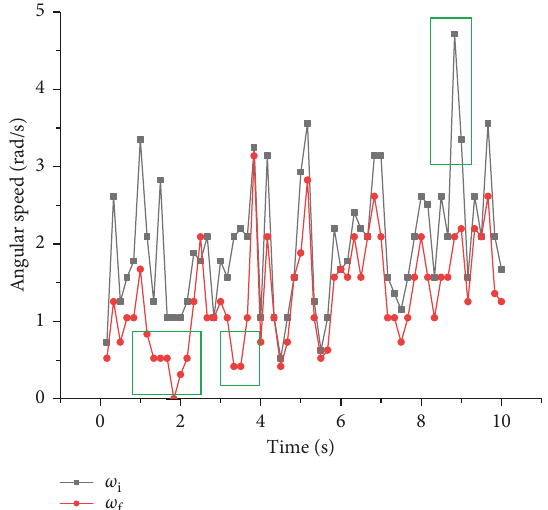
Figure 15: Angular speeds of the sleeve (with 6 rollers) and the shaft.